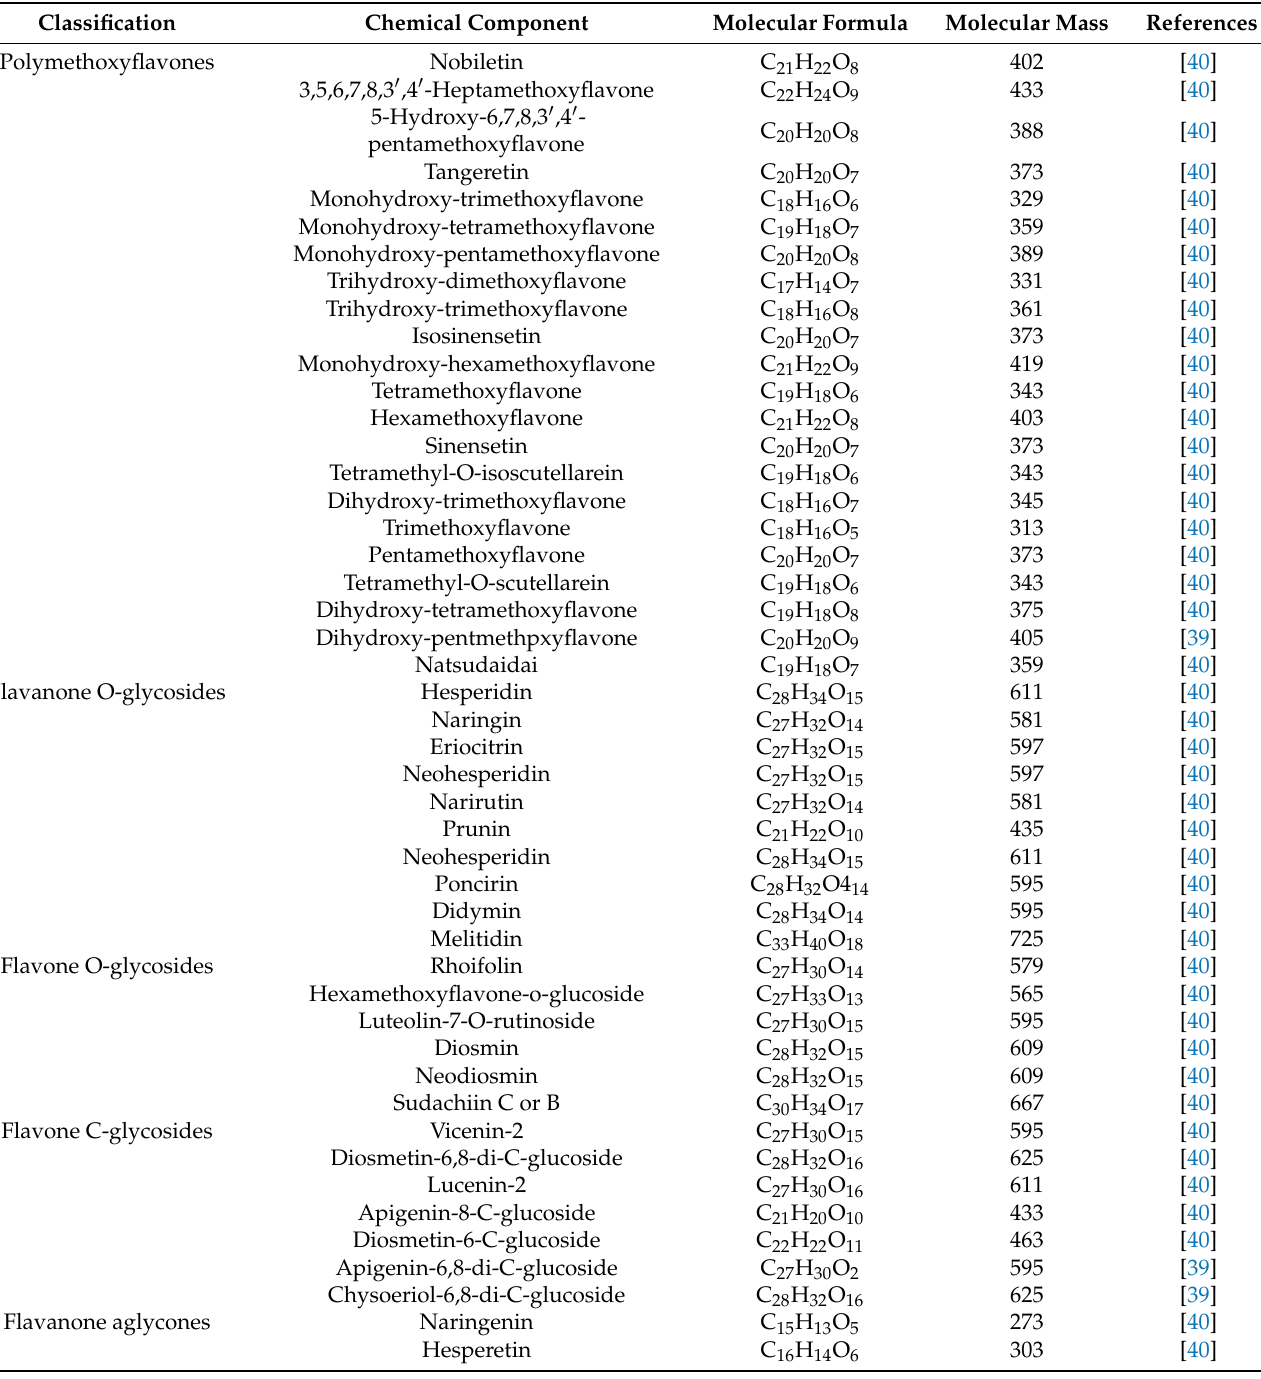
Table 1. The Flavonoids in